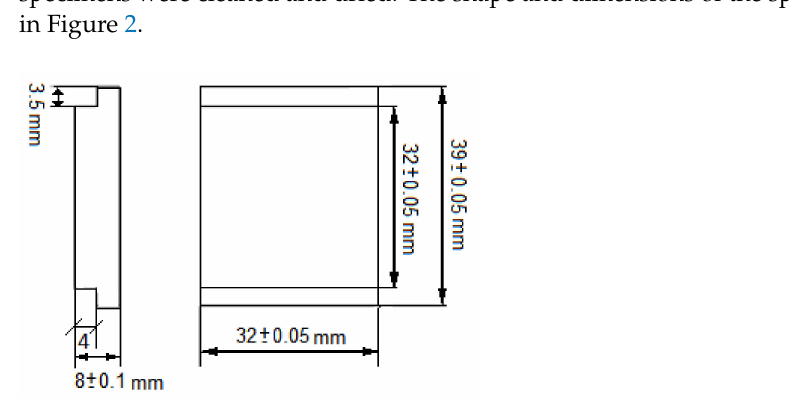
Figure 2. The shape and dimensions of a specimen for cavitation erosion